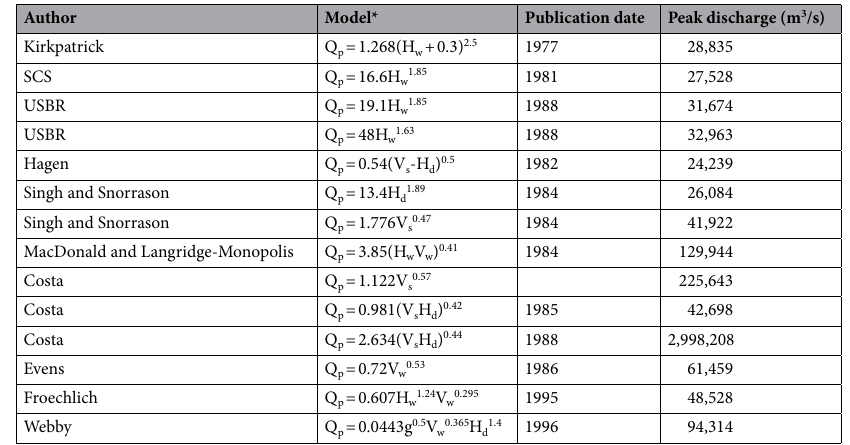
Table 3. Estimates of peak discharge for the outburst flood generated by the 2000 AD Yigong dam failure using 15 empirical models listed in Liu et al. 21 . *Where Q p is the outburst flood peak discharge, V w is the water released (m 3 ), V s is the barrier lake volume, H w is the breach depth, and H d is the dam height. In this study, we only considered complete dam breach; thus, V w is the same as V s , and H w is the same as H d .